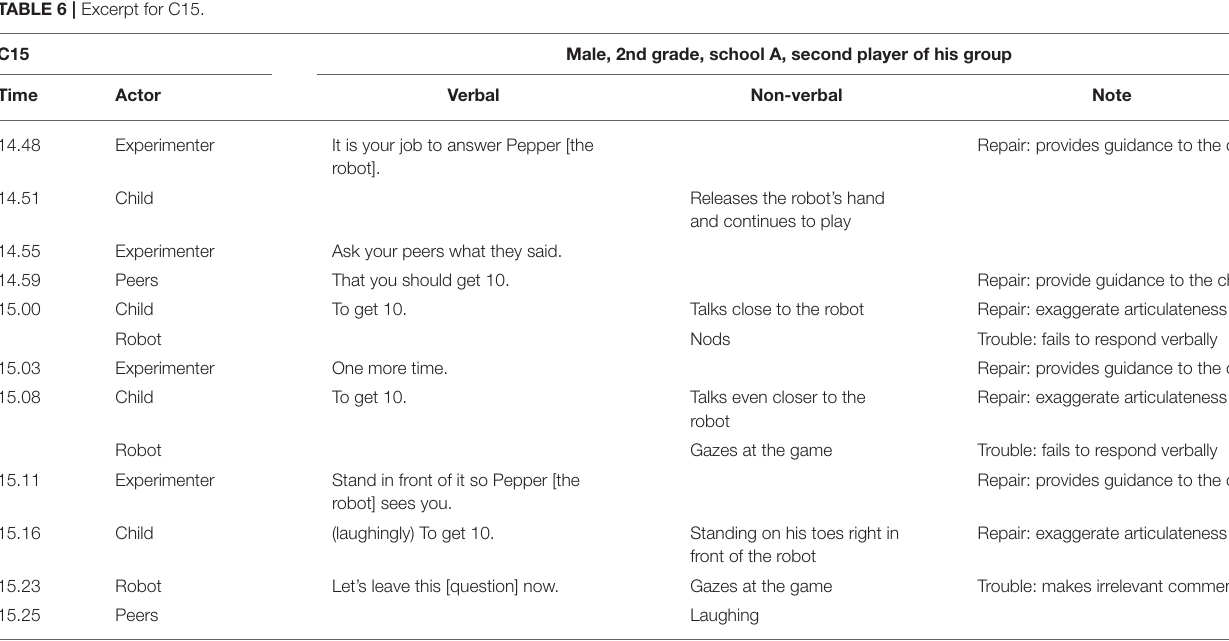
TABLE 6 | Excerpt for